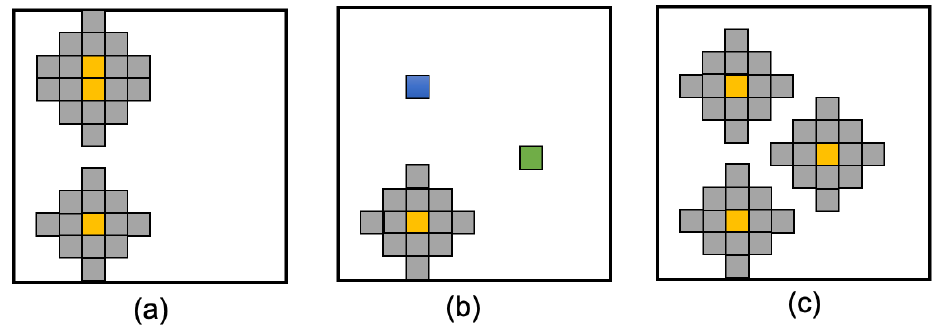
Figure 3. Inflated mapping update between two configurations ( a , c ). ( a , c ) show the expansion maps of the 2D raster map at moments t k − 1 and t k . ( b ) shows the process of handling the raise array. Assume that, at t k − 1 , there are three occupied grids (yellow) in the map. Assume that, at t k − 1 , there are three occupied grids (yellow) in the map. At t k , a newly occupied grid (green) and a disappeared occupied grid (above blue grid) are observed. Firstly, remove the virtual occupied grid created by the raise array and add the mistakenly removed grid (blue) to the lower array. Then, the virtual occupied grid is set near the grids in the lower array to generate the whole inflate map at t k .